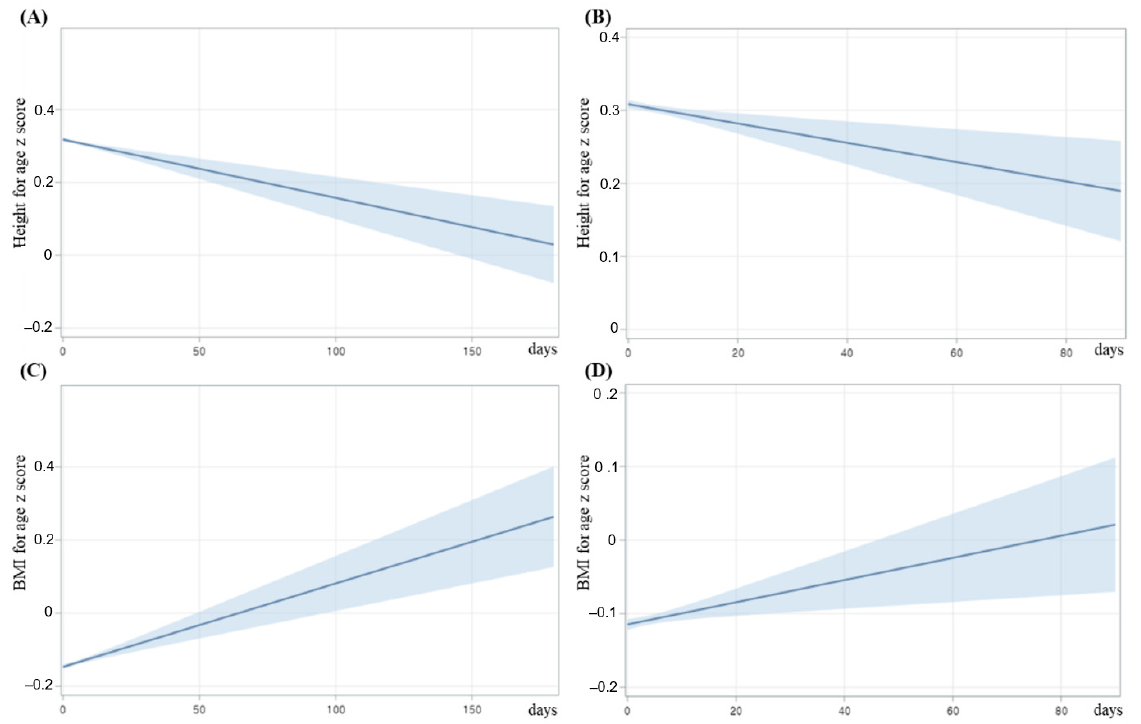
Figure 3. Effect of duration of antibiotic use on HFA z score ( A , B ) and BMI for age z score ( C , D ) in the main cohort ( A , C ) and in the additional cohort ( B , D ). Solid blue lines indicate means and light blue areas indicate 95% CIs.